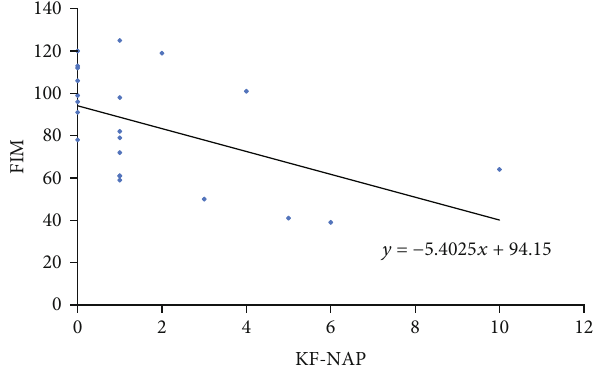
Figure 2: Correlation between KF-NAP and FIM total.